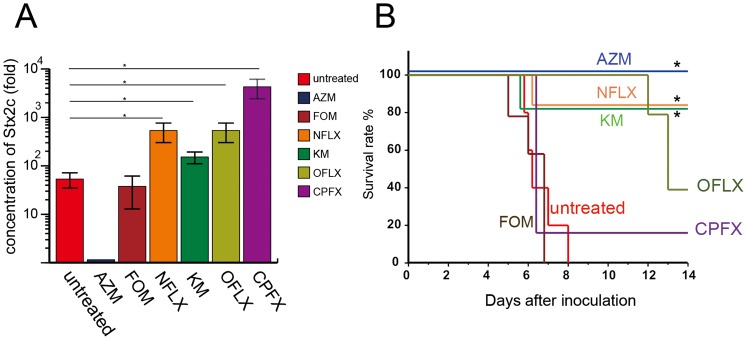
AZM compared with other antimicrobial agents in the E32511 model.(A) The concentration of Stx2c in NFLX, KM, OFLX, and CPFX treatment was significantly increased compared with control (no antibiotic) (NFLX vs. control, p = 0.023; KM vs. control, p = 0.02; OFLX vs. control, p = 0.023 and CPPFX vs. control, p = 0.017), while this was not the case for FOM. On the other hand, AZM statistically decreased Stx2c concentration compared with control (AZM vs. control, p = 0.007). Data were collected from the supernatants of cultures with 2-fold serial dilutions of each antimicrobial agent and are shown as mean and standard deviations of two independent experiments. Statistical difference was measured by Student's t test, *p<0.05. (B) AZM had a statistically significant effect on the mice survival, with 100% survival; NFLX and KM had a statistically significant effect on the mice survival, with 80% survival (AZM vs. untreated, p = 0.002; AZM vs. FOM, p = 0.003; AZM vs. CPFX, p = 0.014; AZM vs. NFLX and KM, p>0.05). Log Rank and χ2 test, *p<0.05.